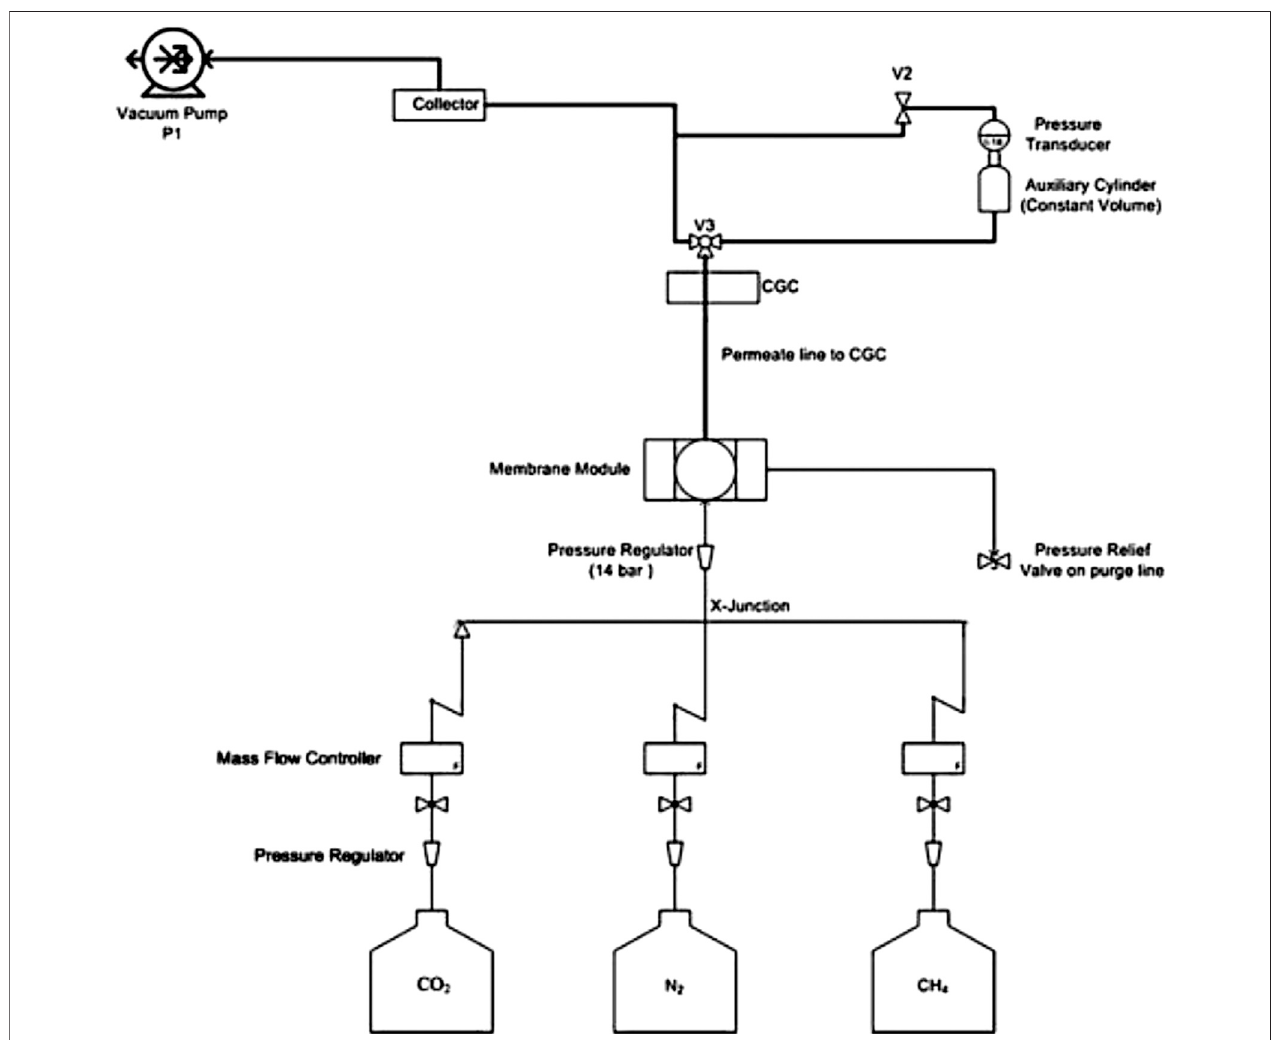
FIGURE 2 | Set-up for pure and mixed-gas evaluation of